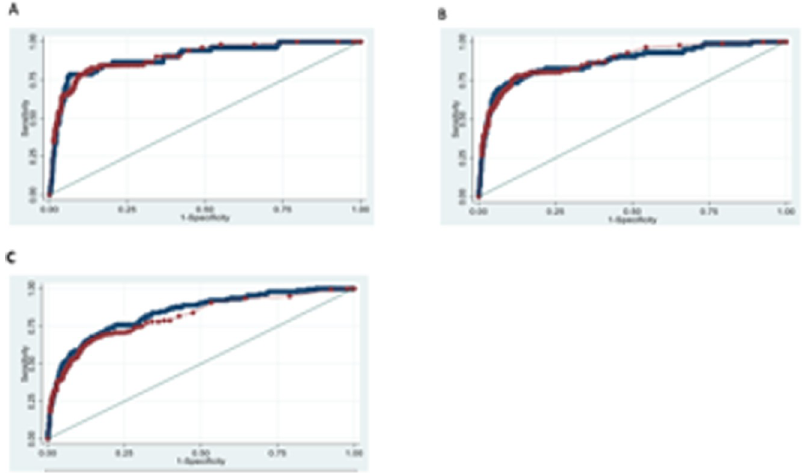
Fig 2. ROC curves for QUiPP and qfFN prediction of sPTB within 7, 14, and 28 days using EQUIPTT participants as validation set. A, B, and C show QUiPP qfFN (blue) and fetal fibronectin alone (red) ROC areas for preterm delivery within 7, 14, and 28 days of respectively. qfFN, quantitative fetal fibronectin; QUIPP, QUantitative Innovation in Predicting Preterm birth; ROC, receiver operating characteristic; sPTB, spontaneous preterm